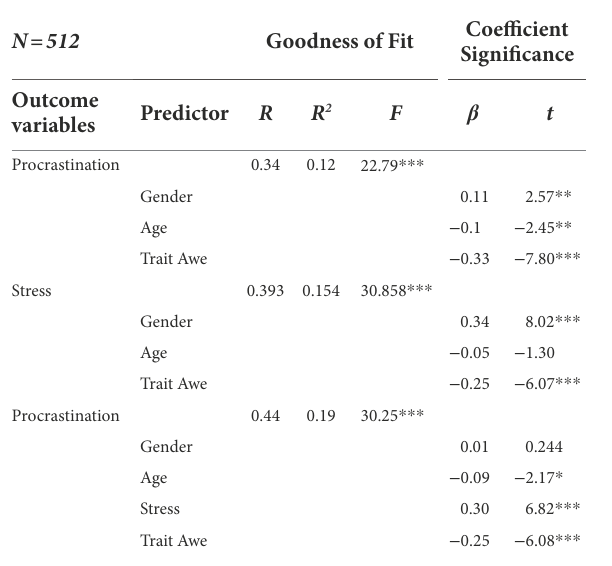
TABLE 2 Mediated model for stress.